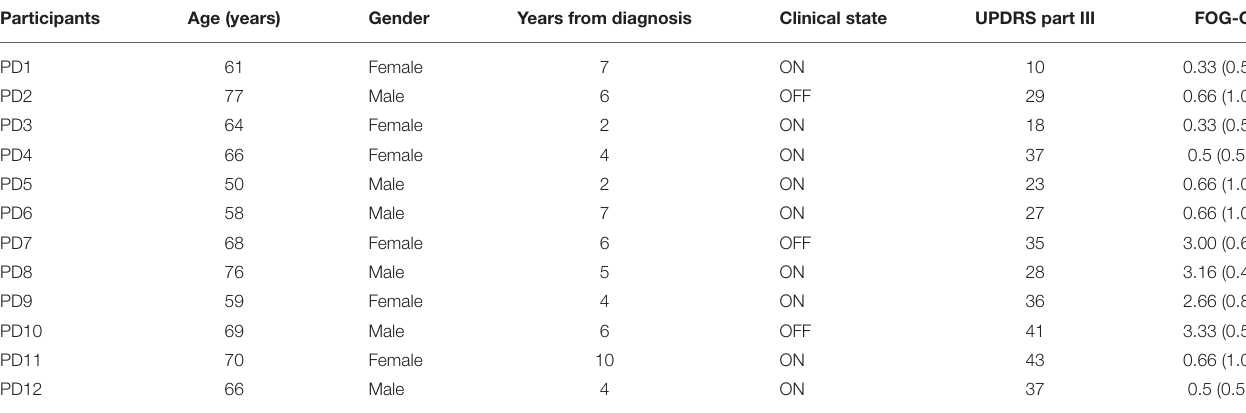
TABLE 1 | Demographic information about the PD participants.